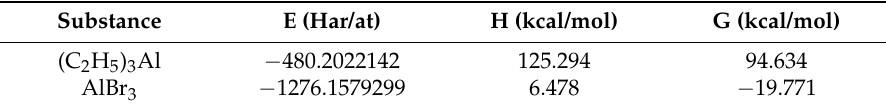
Table 3. Total energy and thermodynamic properties of each component during (C 2 H 5 ) 3 Al preparation at 298.15 K.